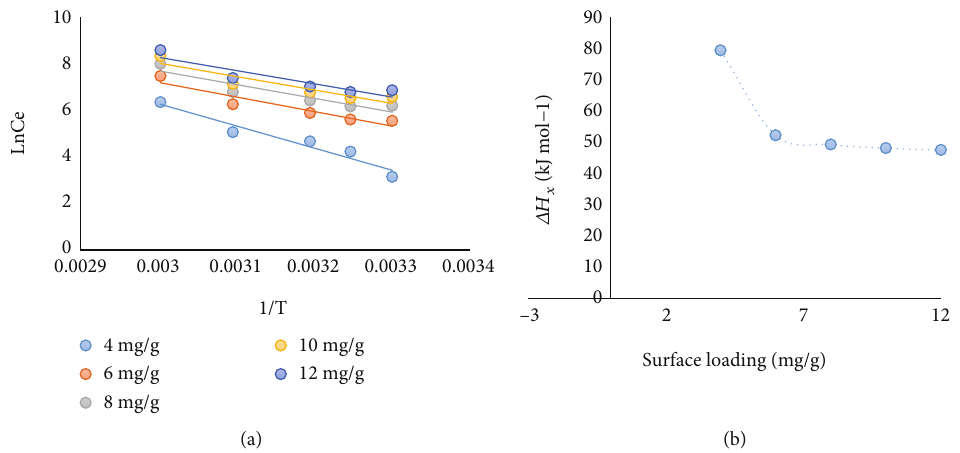
Δ H Δ H x . (b) Plot of x against surface loading.